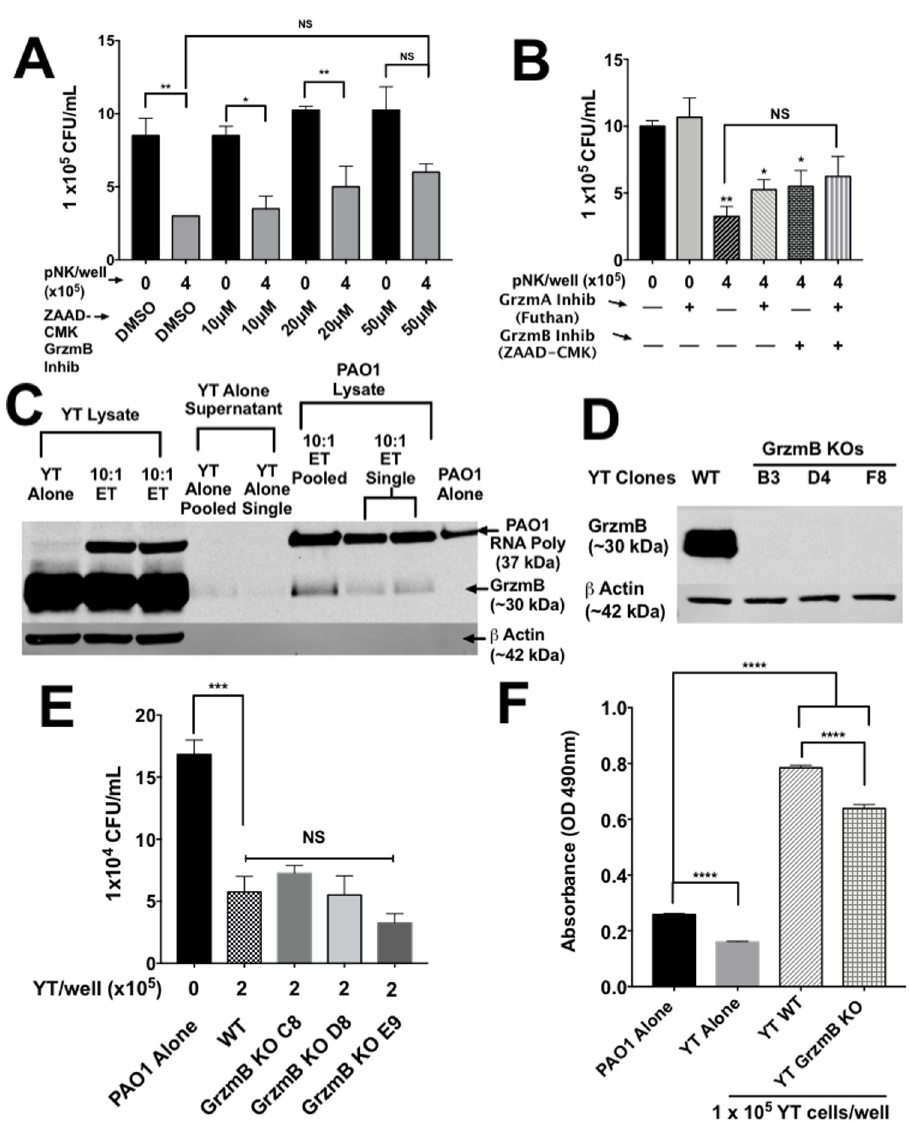
Fig 7. Single KO of GrzmB does not affect YT cell killing of PAO1. (A) PAO1 (1000 CFU/well) incubated alone or in the presence of pNK cells treated with various concentrations of the granzyme B inhibitor ZAAD-CMK or DMSO (control). (B) Untreated pNK treated with 50 μ M ZAAD-CMK, 0.25 μ M granzyme A inhibitor (Futhan) or both and cultured for 6 h then plated to determine CFU. � = P � 0.05 and �� = P � 0.01. (C) Western blot analysis of Grnz B in YT cells (1x10 6 cells), PAO1 or culture media from 6 h co-cultures at a 10:1 ET ratio. PAO1 was separated from YT cells and culture media using a series of centrifugation and washes with sterile distilled water to separate the bacteria which were lysed with 2x Sample Buffer and boiled. Bands were revealed using (1:1000) mouse antibodies specific for human Grzm B. Rabbit antibody specific for human beta actin and a rabbit antibody specific was E . coli RNA polymerase were used as loading controls for the YT and PAO1 cells respectively. (D) Western blot analysis of wild type and granzyme B knockout (C8, D8 and E9) YT cells (5x10 5 cells). Blotted using (1:1000) mouse antibodies specific for human Granzyme B (clone: m3304b06). (E) PAO1 incubated alone or in the presence of wild type or GrzmB knockout YT cells and cultured for 6 h before determining CFU. (F) PAO1 incubated alone or in the presence of WT or GrzmB KO YT cells for 6 h. Nitrocefin (1mM) was added for 12 h. In all co-culture experiments, conditions were carried out in n = 4 wells (mean ± SEM) and the graph is representative of n � 3 biological replicates. � = P � 0.05, �� = P � 0.01, ��� = P � 0.001.